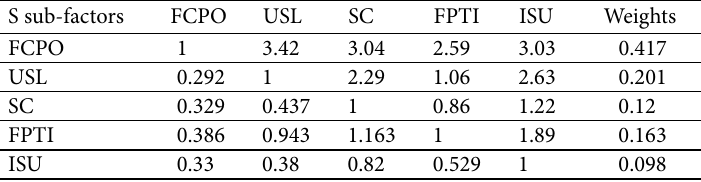
Table 6. Local weights and pairwise comparison matrix of social